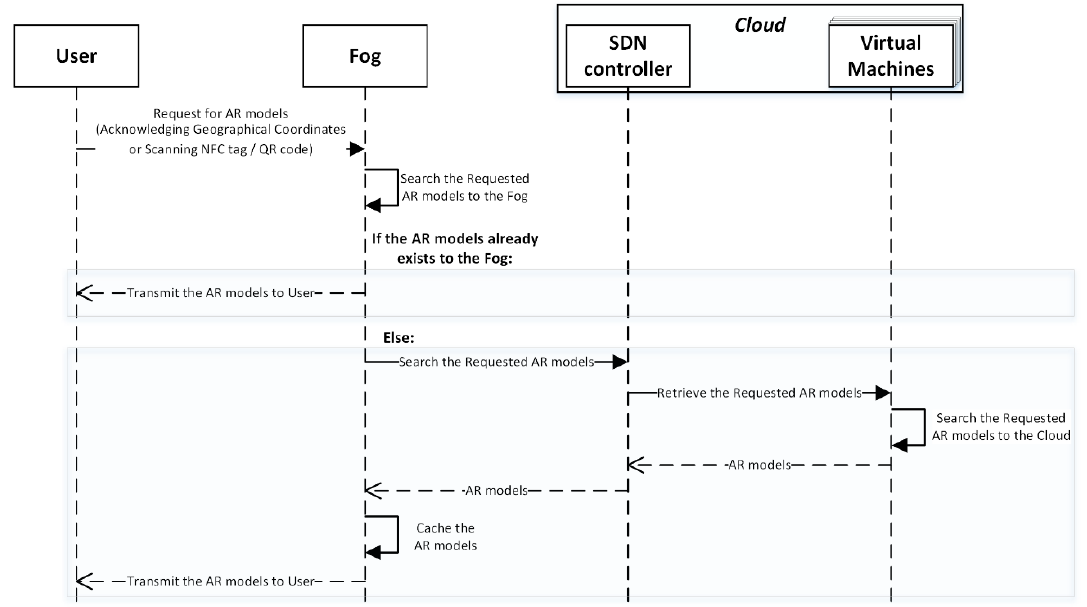
Figure 7. The sequence diagram indicating the functionality of the proposed